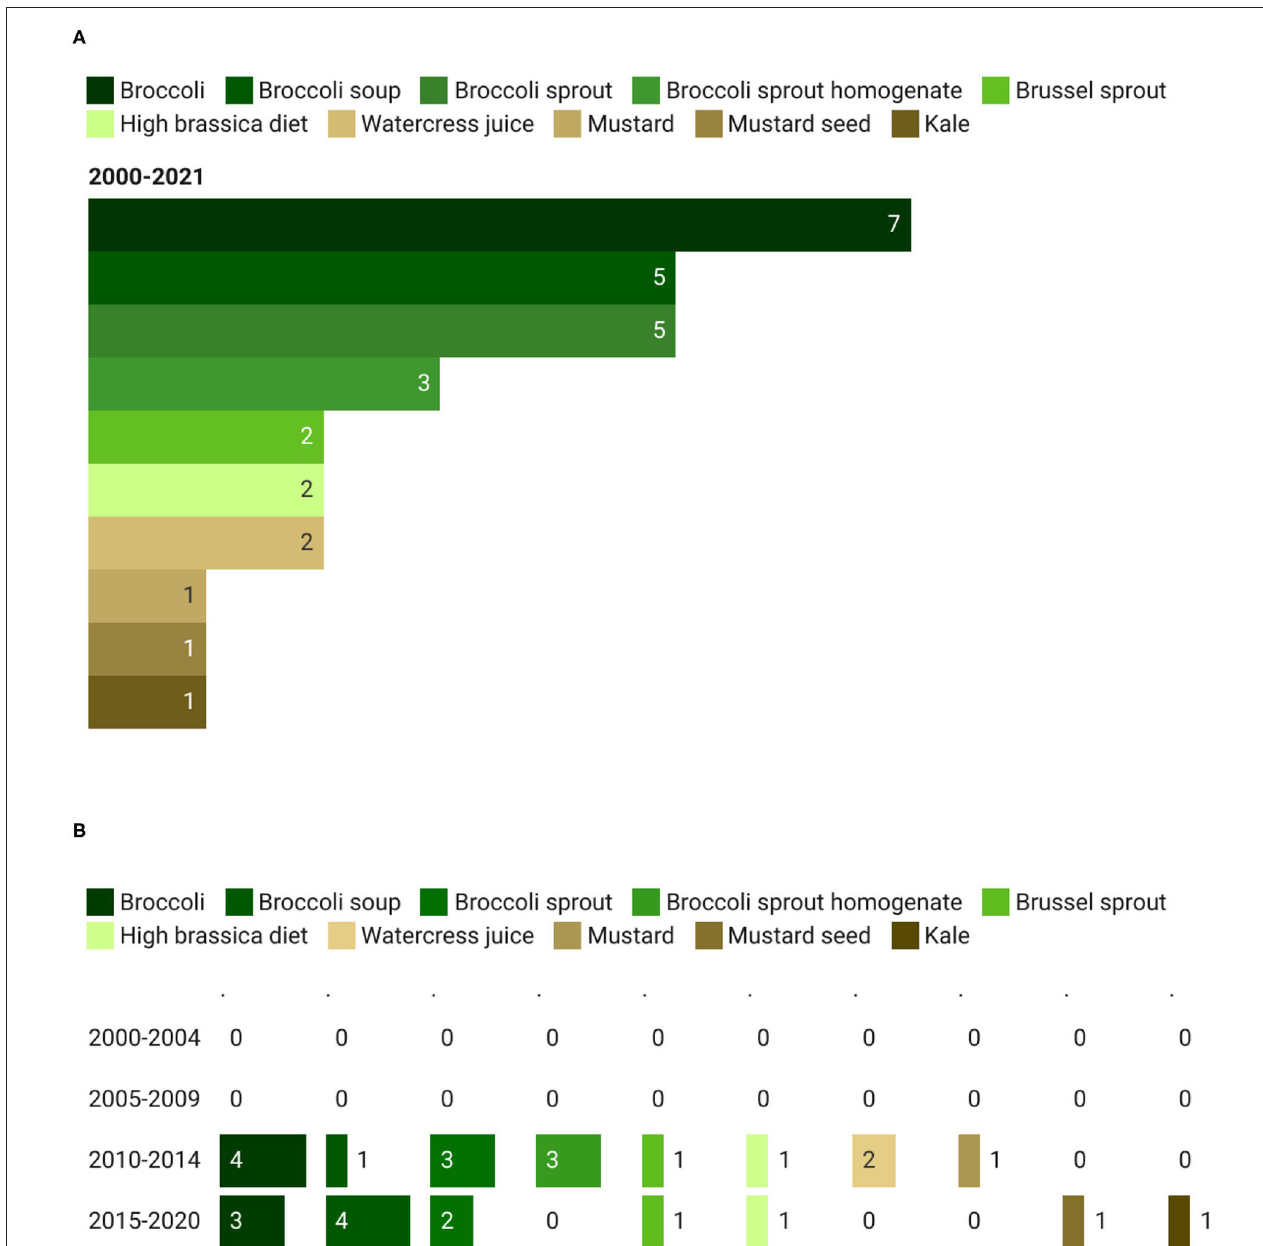
FIGURE 3 | Main glucosinolates (GSL)-rich foods (A) used in clinical trials and their trend (B) . The total count of GSL-rich foods is higher than the total count of the corresponding studies since in some studies more than one food has been provided to the participants.